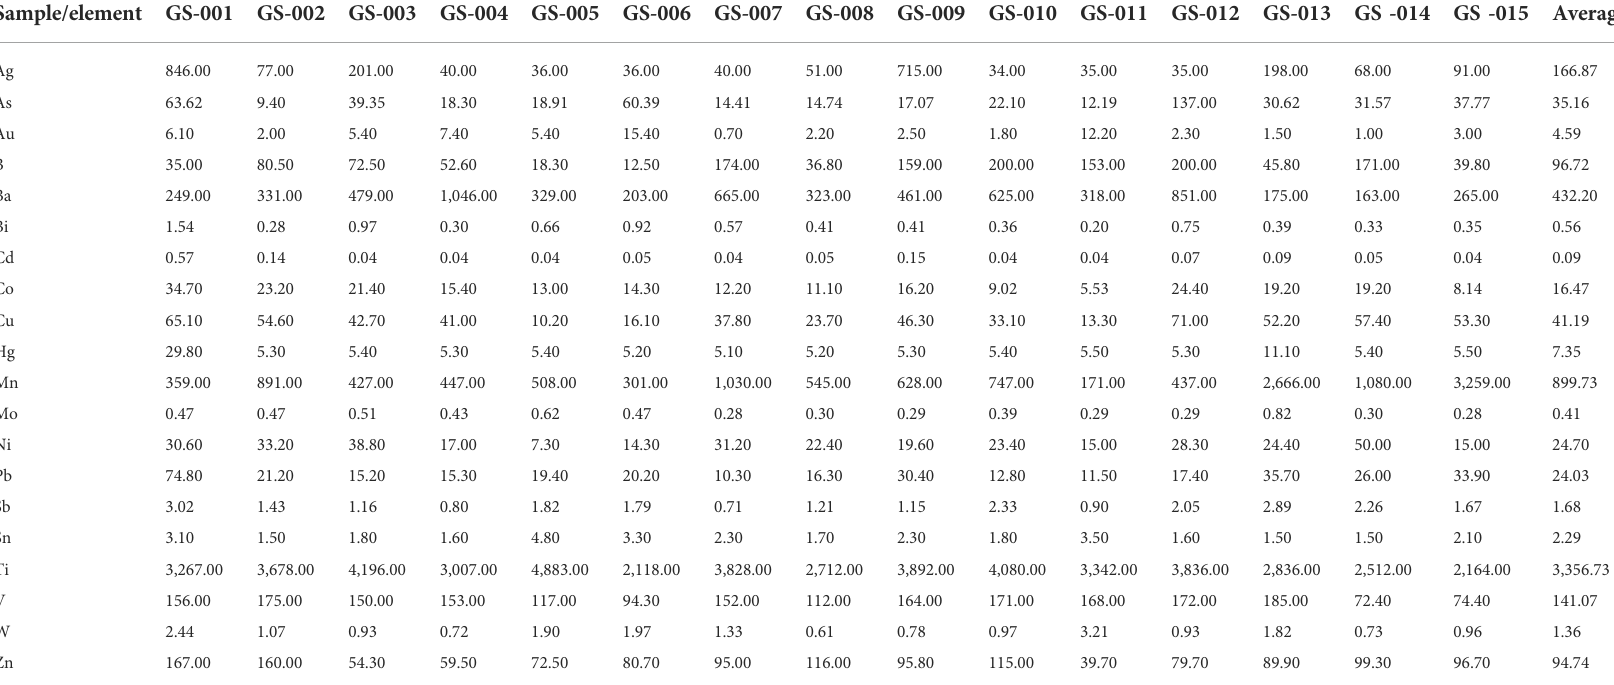
TABLE 3 Gold and path fi nder elements in altered rock samples from the Hongqigou tectonic zone (Ag and Au in ppb, other elements in